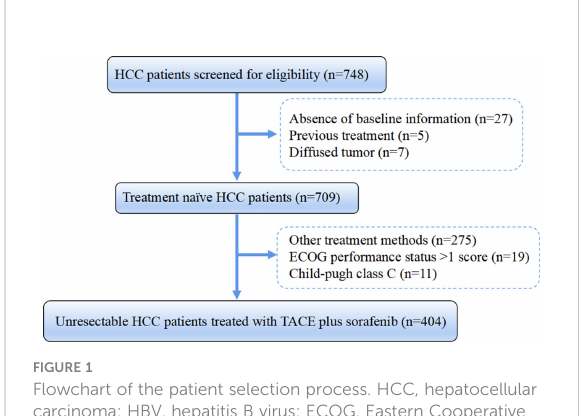
FIGURE 1 Flowchart of the patient selection process. HCC, hepatocellular carcinoma; HBV, hepatitis B virus; ECOG, Eastern Cooperative Oncology Group; TACE, transarterial